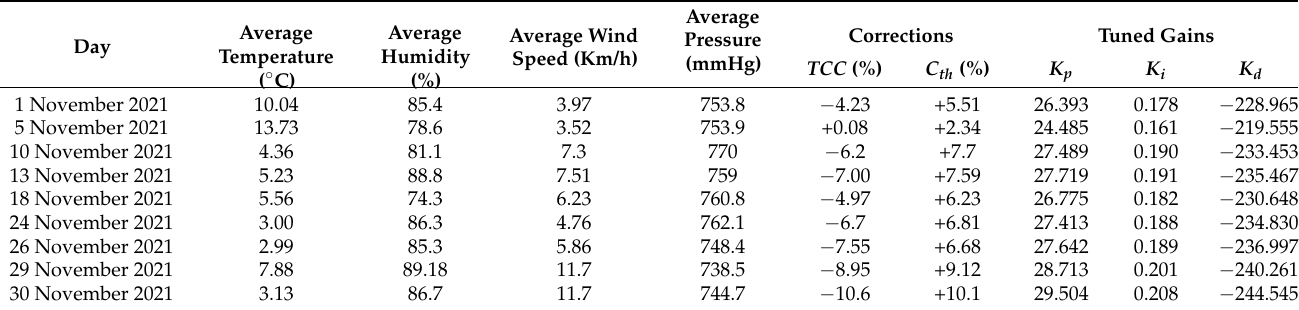
Table 3. A selection of different TCC and C th corrections.